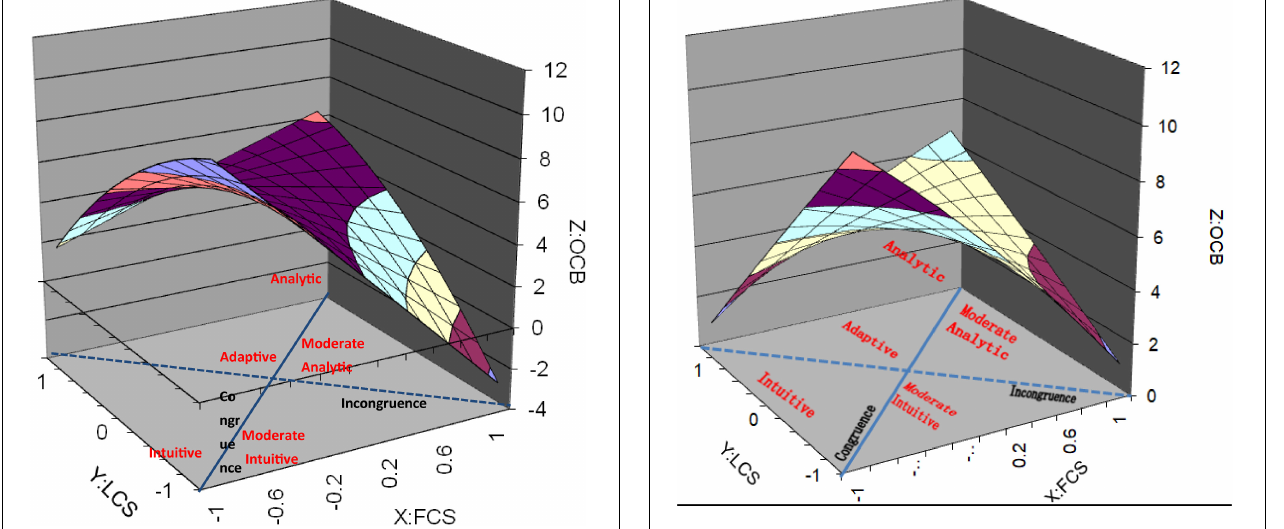
FIGURE 1 | Response surface graph of overall OCB.